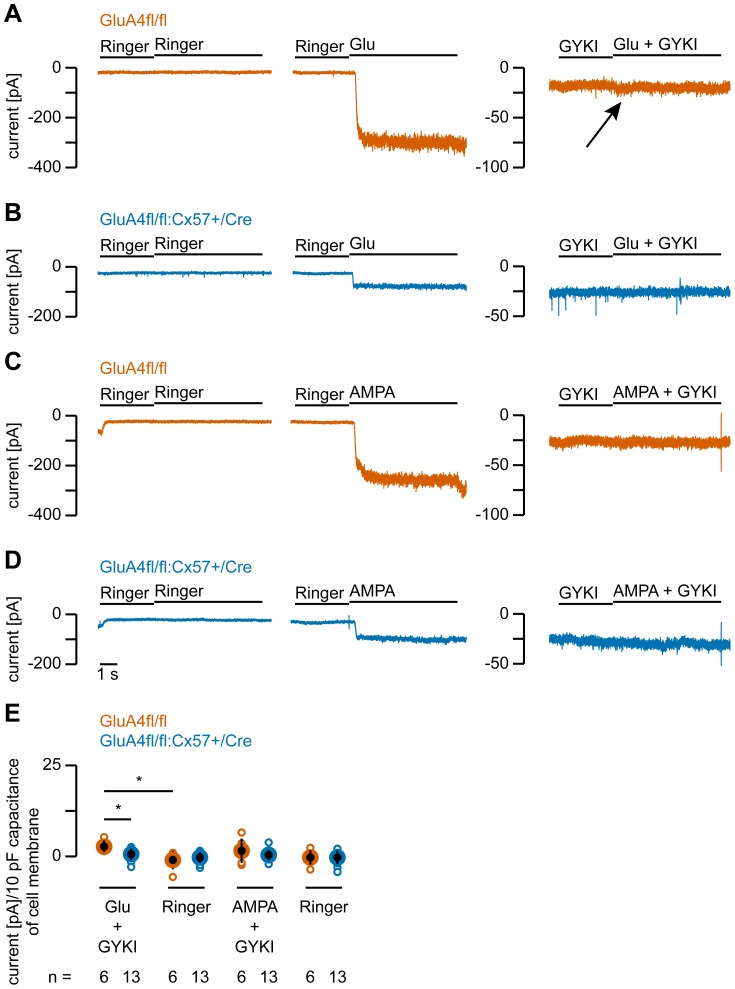
The residual glutamate-induced current in GluA4-deficient horizontal cells is mainly mediated by AMPA receptors.
A-D, Representative current traces recorded from GluA4-expressing (A, C) and GluA4-deficient horizontal cell somata (B, D) at a holding potential of –70 mV. When the AMPA receptor antagonist GYKI52466 (100 µM) was present, glutamate (Glu, 1 mM; A, B, E) only induced a detectable current in GluA4-expressing cells (A,E) but not in GluA4-deficient cells (B, E). AMPA-induced responses were completely abolished by GYKI52466 in both genotypes (C-E). E, Quantification of glutamate- and AMPA-induced currents upon GYKI52466 application. GYKI52466 reduced the amplitudes of glutamate- and AMPA-induced currents by 98.9% in controls and 99.3% in GluA4-deficient mice, indicating that most of the glutamate-induced current is mediated by AMPA receptors. Current amplitudes in E are normalized to 10 pF capacitance of cell membrane to account for differences in cell size. Small circles represent values for individual cells; large, black filled circles represent the means; error bars show SD. n specifies the number of measured cells. *, p < 0.05.